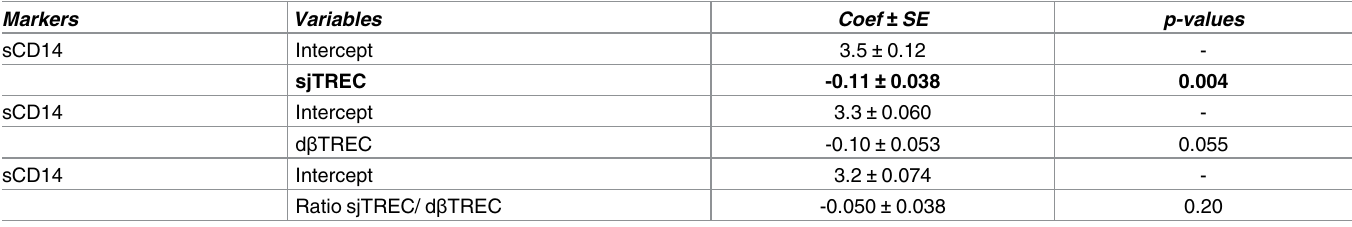
Table 3. Impact of TRECs on sCD14 * (N =